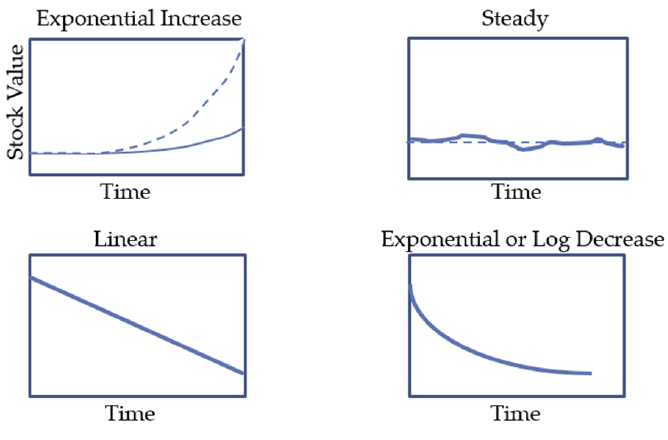
Fig. 3. Behavior-over-time